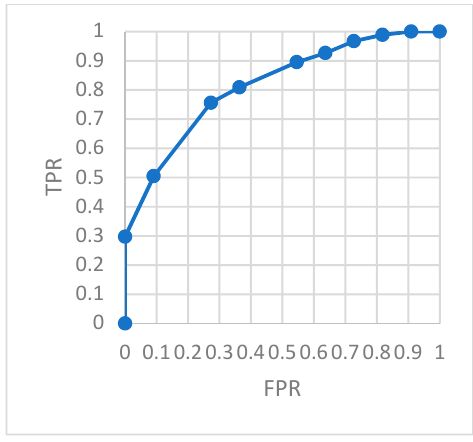
Figure 20. ROC of AutoEncoder in test set 2.